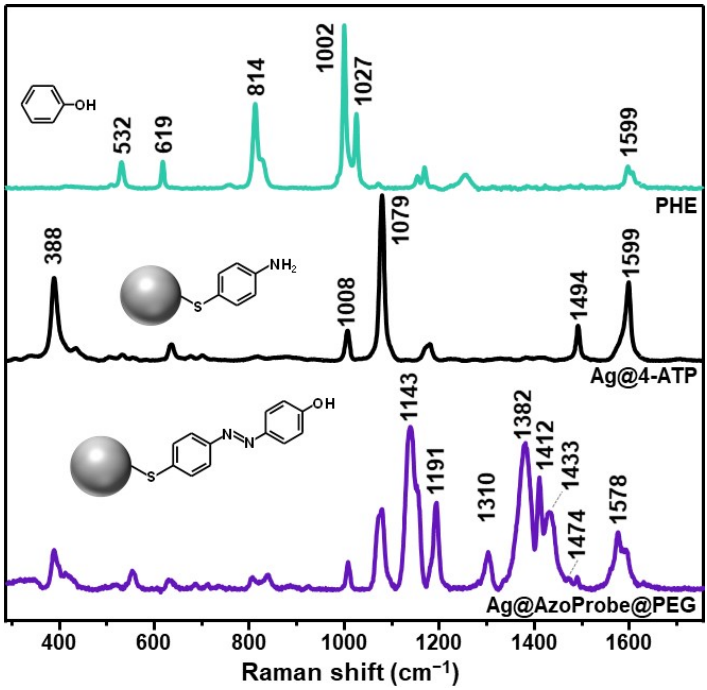
Figure 3. Normal Raman spectrum of phenol (PHE) and SERS spectra of 4-ATP on aggregated AgNPs and AzoProbe in Ag@AzoProbe@PEG clusters.